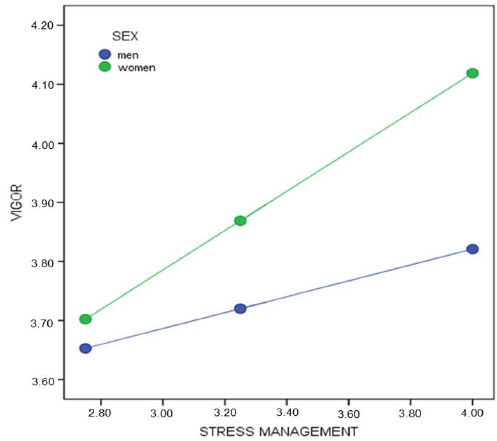
ff ect of stress management on vigor by sex. Figure 2. Conditional effect of stress management on vigor by sex Figure 2. Conditional e Figure 2. Conditional effect of stress management on vigor by sex